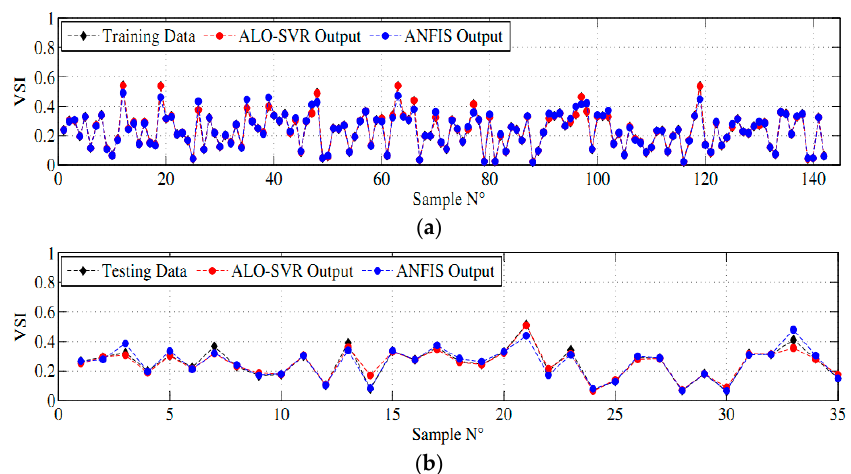
Figure 4. Comparisons between the actual and predicted values of VSI for IEEE 118-bus in ( a ) Training process; ( b ) Testing process.